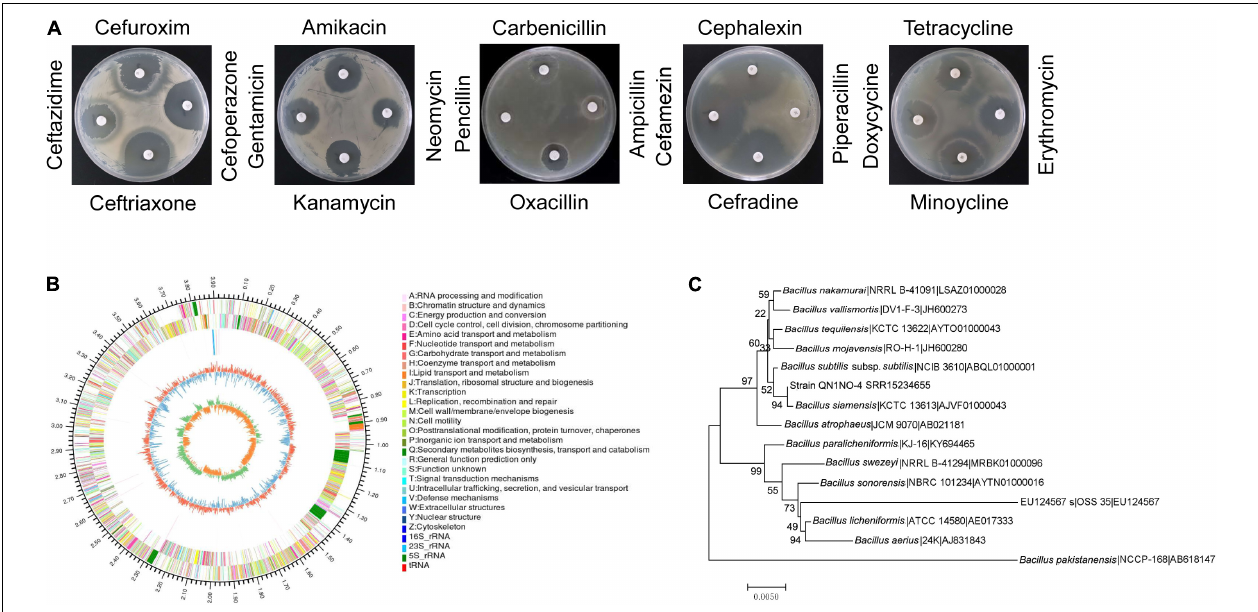
FIGURE 2 | Identification of strain QN1NO-4. (A) Antibiotic sensitivity test of strain QN1NO-4. (B) Circular map of the strain QN1NO-4 genome. From outside to center, ring 1 represented the genome-size marker. Rings 2 and 3 showed coding sequences on forward and reverse strands, respectively. Ring 4 demonstrated rRNAs and tRNAs. Ring 5 represented the G + C content, followed by G + C skew in ring 6. (C) Phylogenetic tree of strain QN1NO-4 based on the 16S rRNA sequence. The tree was constructed using the neighbor-joining method in the MEGA software. The level of bootstrap support (1,000 repetitions) was indicated at all